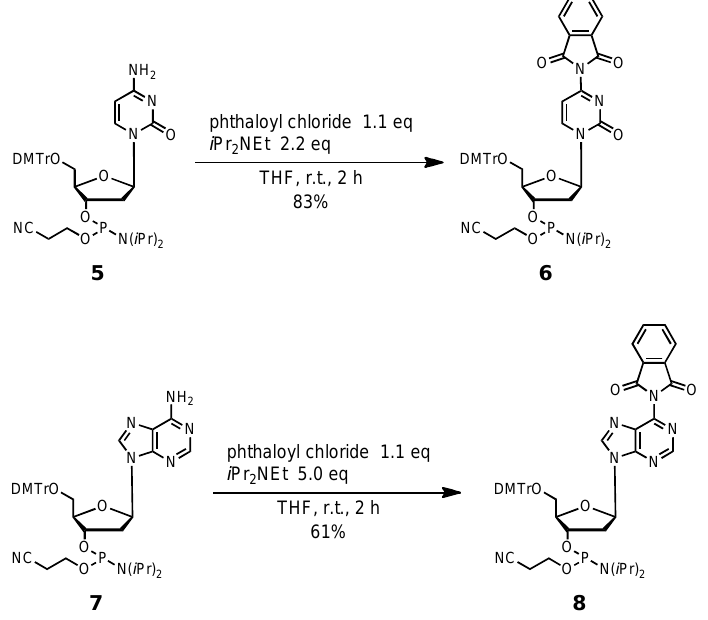
Synthesis of fully protected 2 ′ -deoxycytidine derivative 6